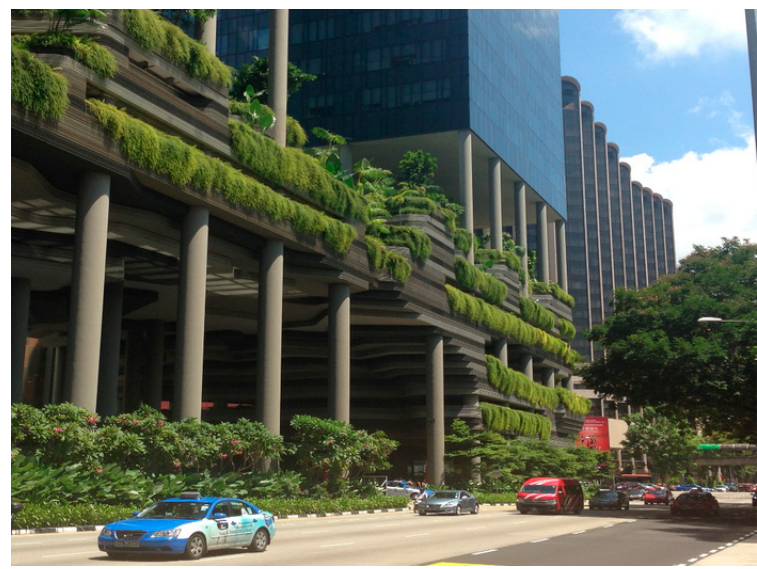
Figure 6. Park Royal Hotel in Singapore shows the city’s commitment to biophilic urbanism, a component of the regenerative city agenda (source, Peter Newman).